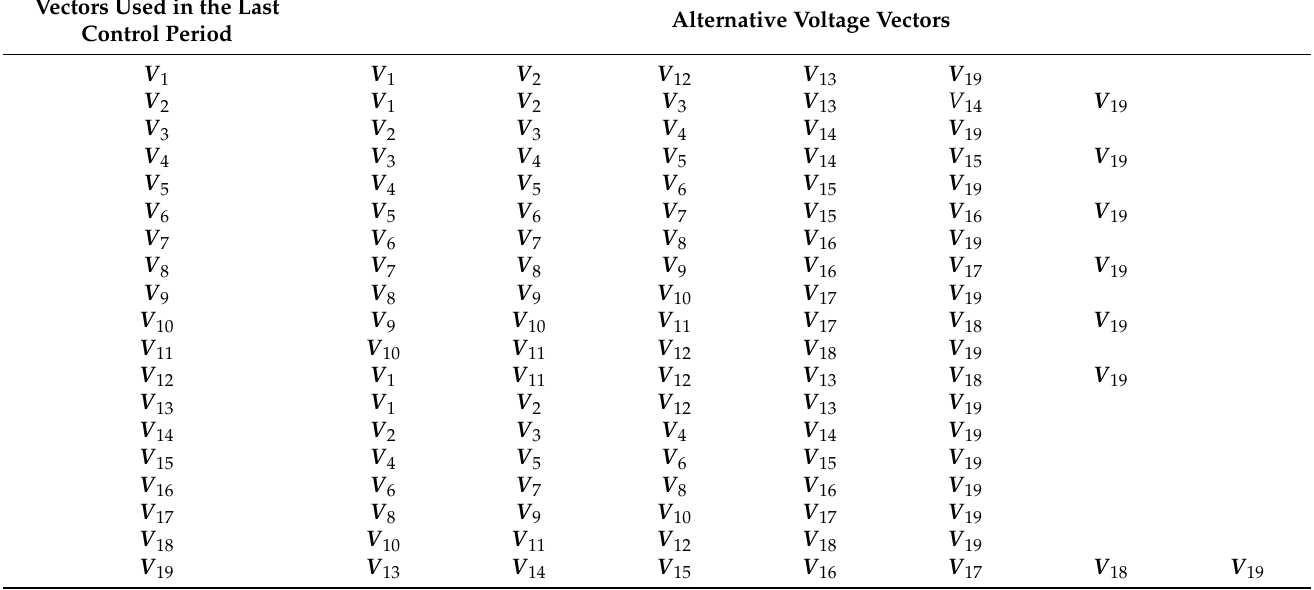
Table 2. Alternative voltage vectors of conventional